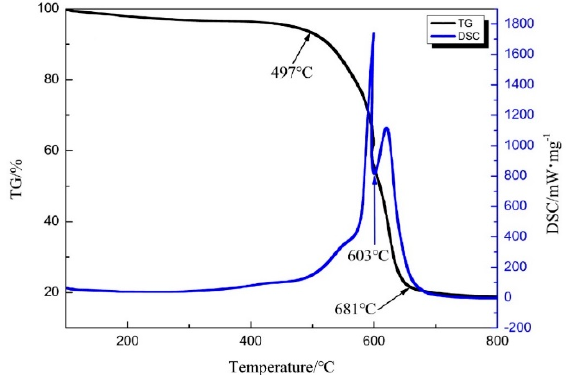
Figure 3. TG-DSC analysis of the soot.